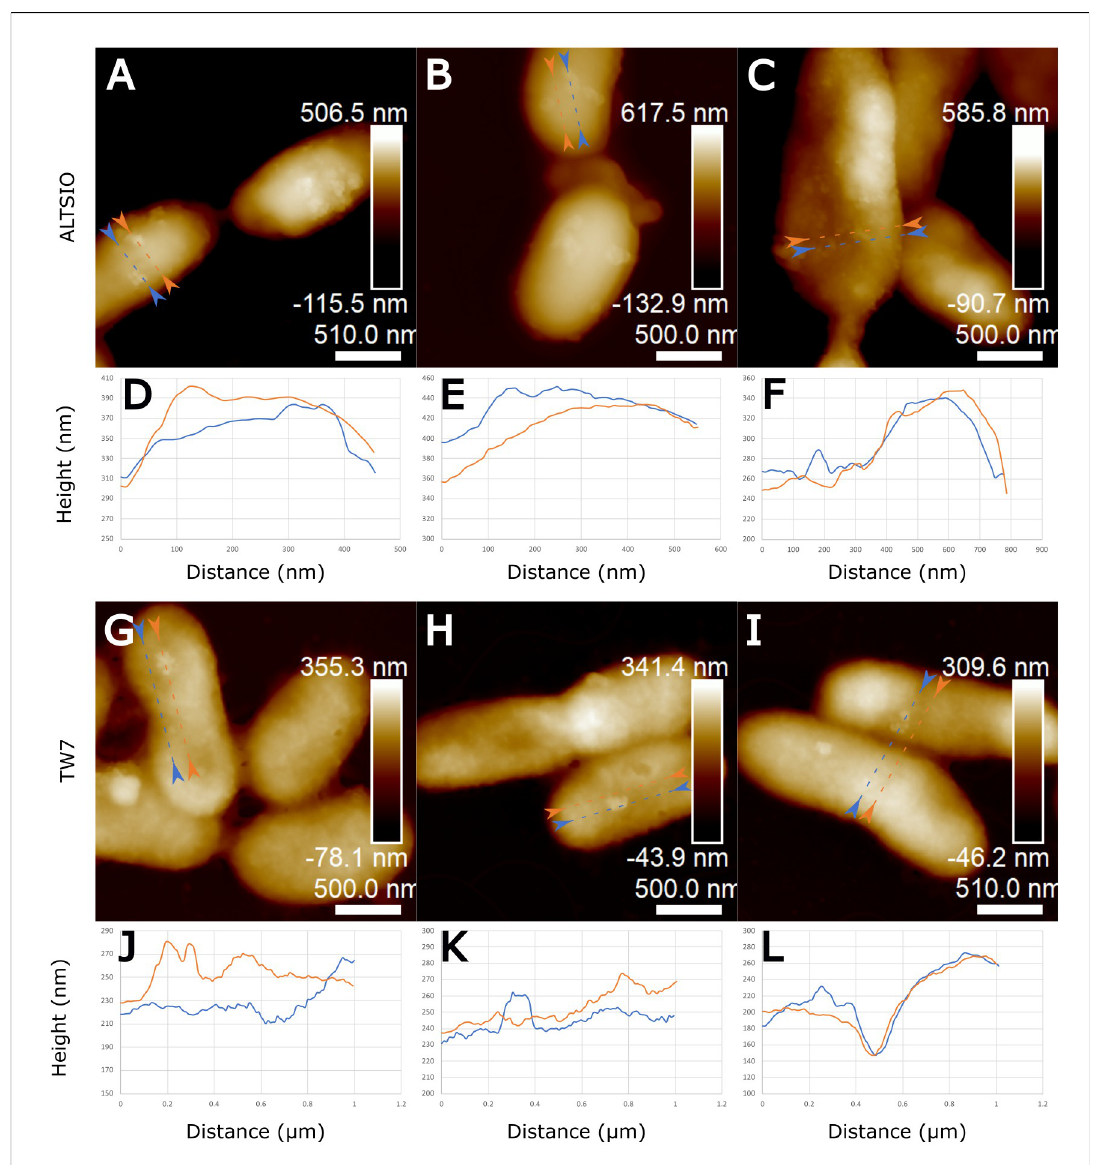
Fig 2. Surface profiles of individual ribosome particle clusters. AFM height images with demarcated line sections (blue and orange dashed lines and arrowheads) of surface-attached particle clusters of ribosomes on ALTSIO cells (A-C) and TW7 cells (G-I) . Respective surface profiles of paired line traces show the height dimensions of such features with reference feature-free profiles from proximate cell surface regions ( D-F : ALTSIO and J-L : TW7); corresponding to respective line sections in AFM images. Most discrete surface-attached particle clusters are roughly 40–200 nm in width and 10–30 nm in height, corresponding to several multiples of ribosome particles. Image scale bars